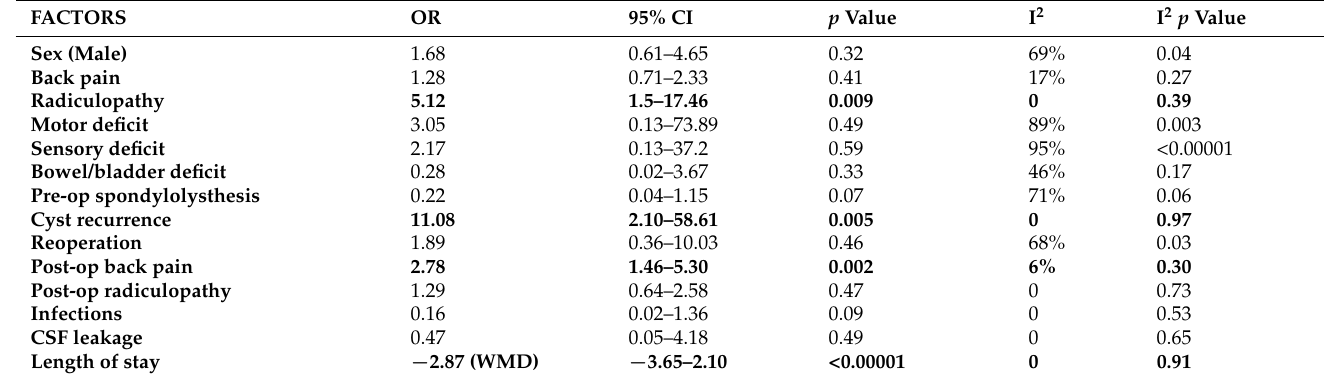
Table 2. Summary of the results of the meta-analysis. (OR = Odds Ration; CI = Confidence